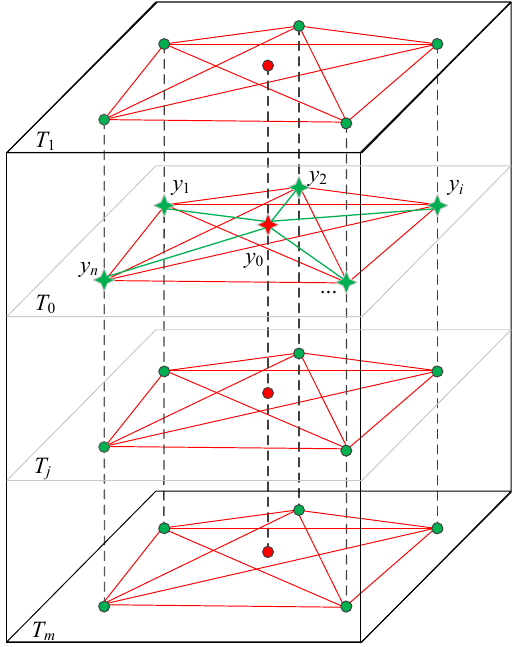
Figure 3. Interpolation in the spatial dimension.